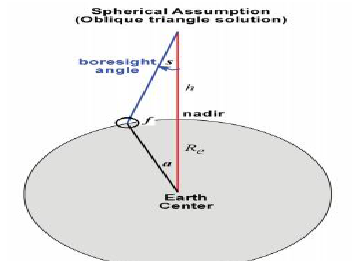
Figure 4. Spherical assumption geometry using the Oblique